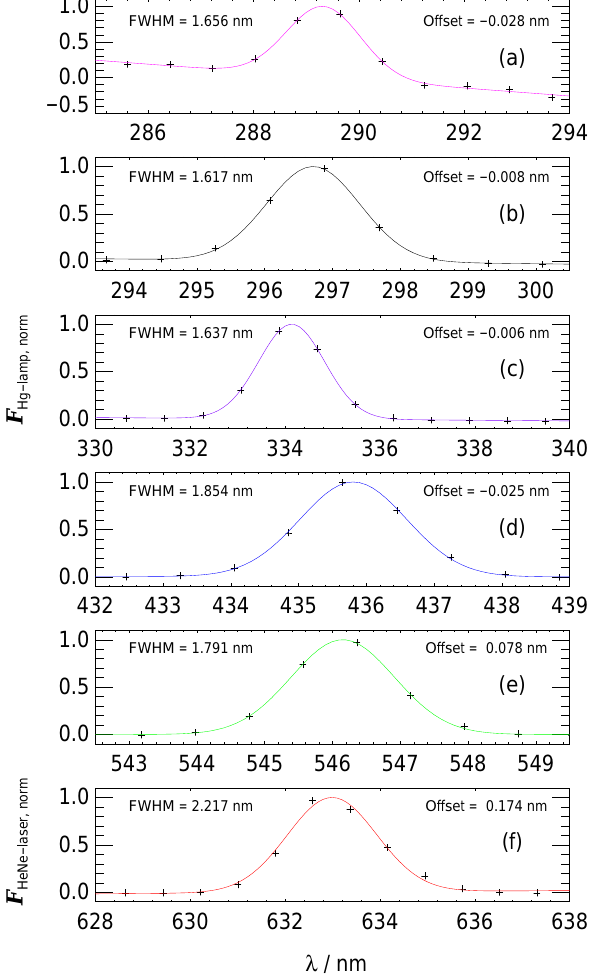
Figure 2. Selected sections of background-corrected, normalized low-pressure Hg-lamp spectra (a) – (e) and of a HeNe laser spec- trum (f) , obtained with instrument 62001 and corresponding emis- sion line fits of Eq. (4) (full lines). Wavelengths correspond to manufacturer-based third-order polynomials of pixel numbers. In- dicated wavelength offsets and FWHMs of emission lines were ob- tained from parameters a 1 to a 3 of Eq. (4). Emission lines in figures (a) – (f) correspond to in-air wavelengths listed in the first column of